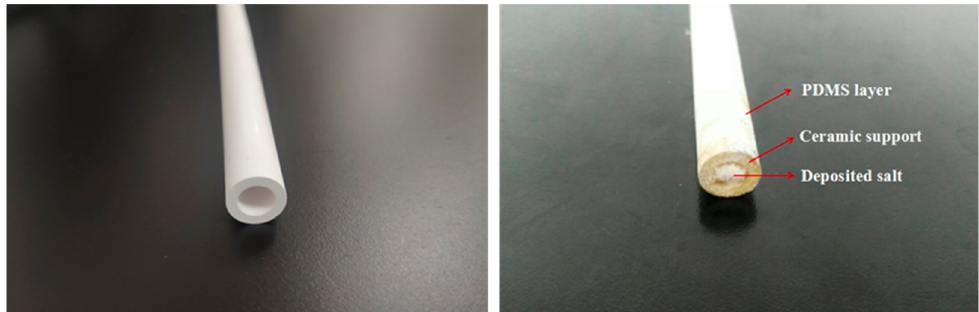
Figure 5. Virgin ( left ) and fouled ( right ) PDMS/ceramic tubular membranes.